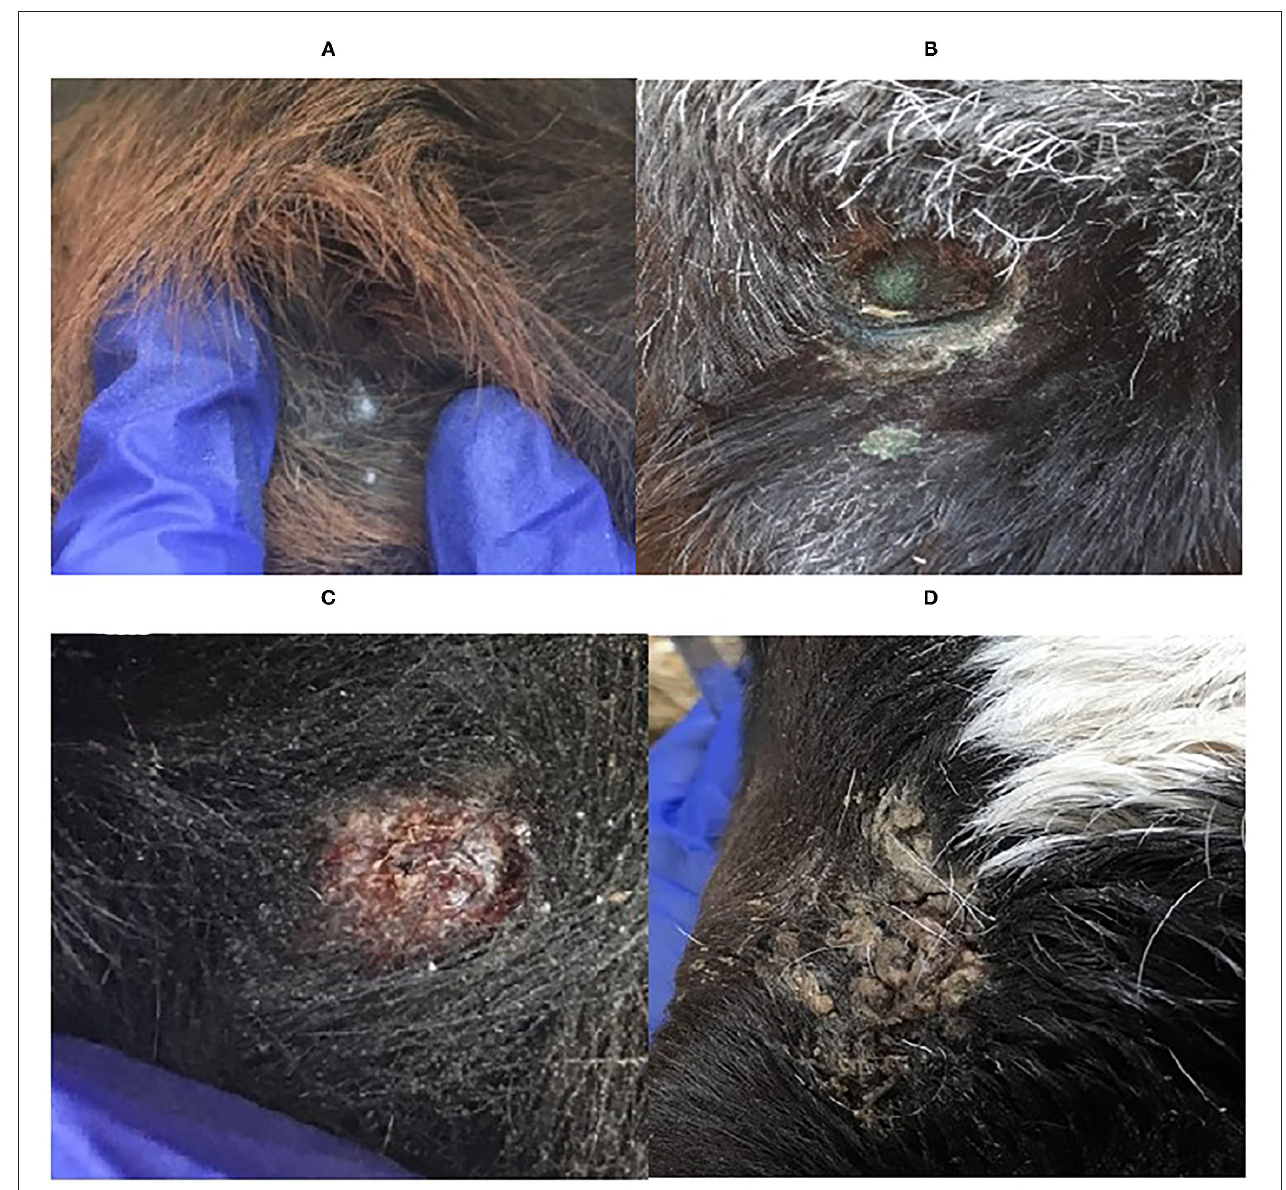
FIGURE 2 | Photographs showing the three different lesion scores used in the study. (A) healed (H), (B) and (C) normal healing (NH), and (D) abnormal healing